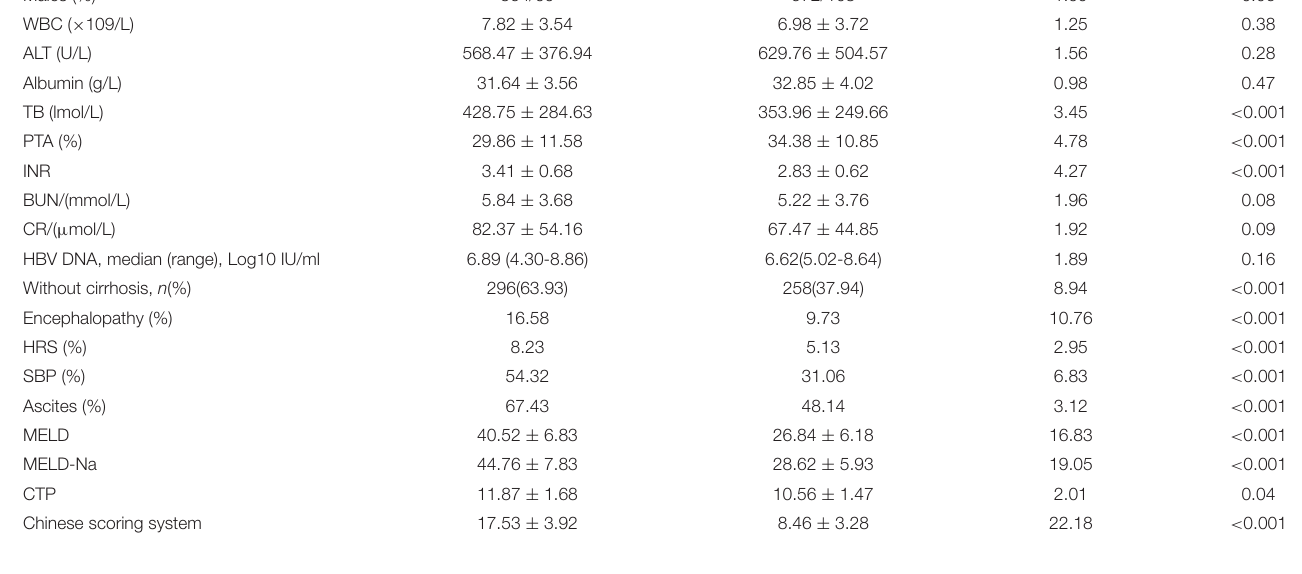
TABLE 2 | Baseline characteristics of included patients at admission. Parameters